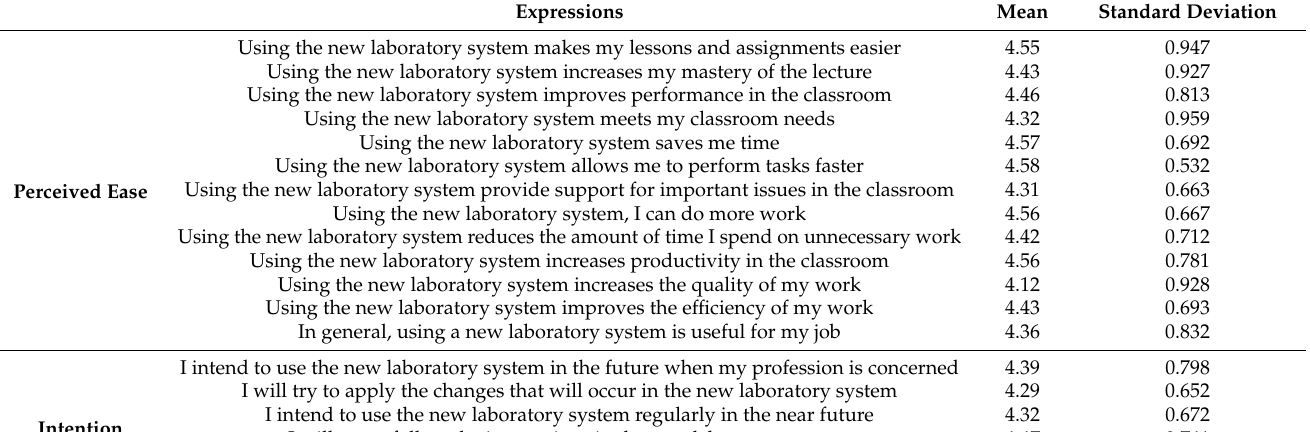
Table 4. Mean and standard deviation values of TAM components.